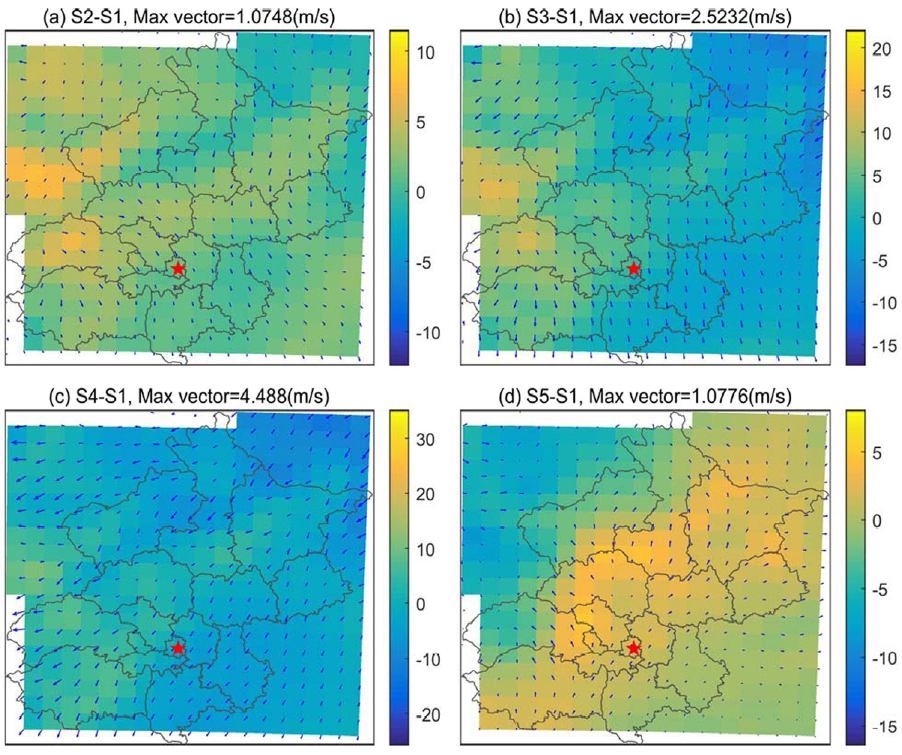
Figure 6. The composite anomaly fields of surface wind vectors and relative humidity for S2-S1 ( a ), S3-S1 ( b ), S4-S1 ( c ) and S5-S1 ( d ),